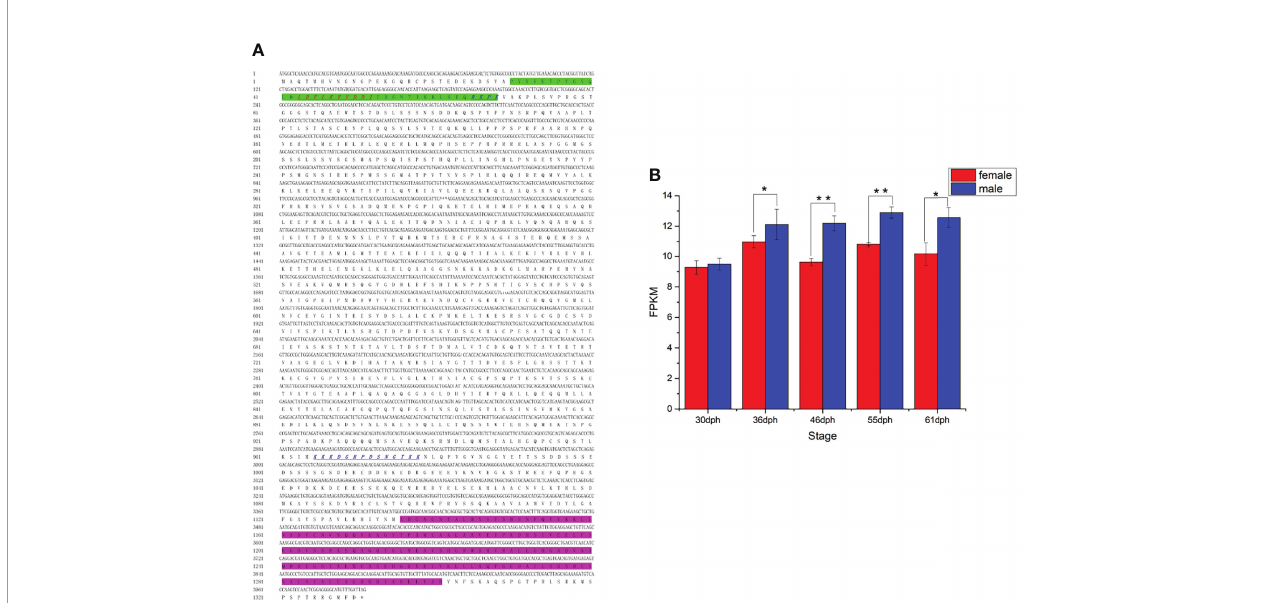
FIGURE 7 | (A) The cDNA and deduced amino acid sequence of kank1 gene. The Kank1 KN N-terminal motif (KN) motif (green shadow) and ankyrin repeat domains from the C-terminal are marked. The sequences of NLS and NES motifs identi fi ed in Kank1 are underlined by blue italics and red italics, respectively.